Question: How would you classify this visualization?
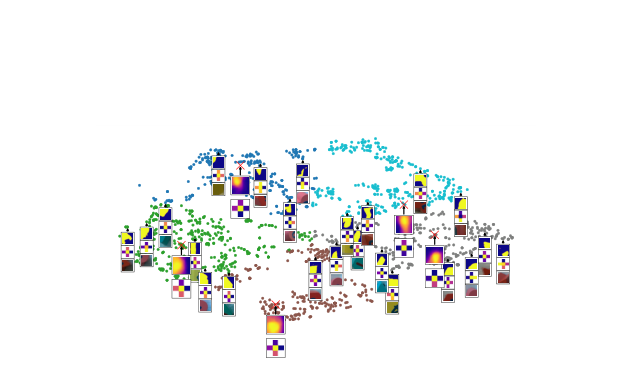
Answer: scatter